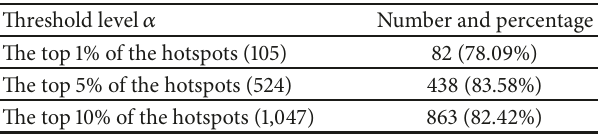
Table 13: The number of hotspots identified by both the carcass removal data and the reported AVCs data using the GNB-based EB estimates.